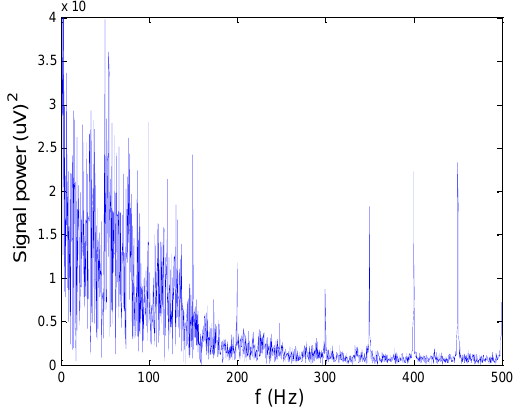
Figure 14. Frequency spectrum of raw EMG signal shown in Figure